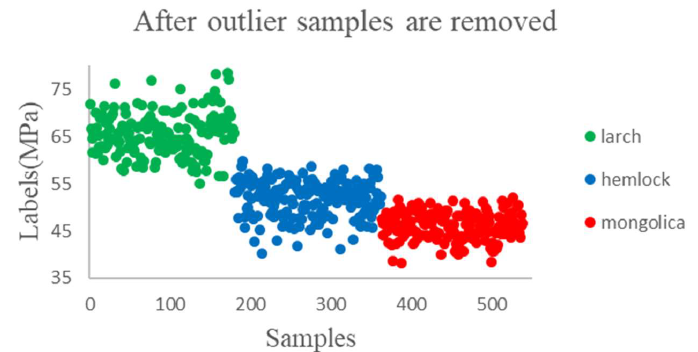
( b ) After the rejection of outlier sample.